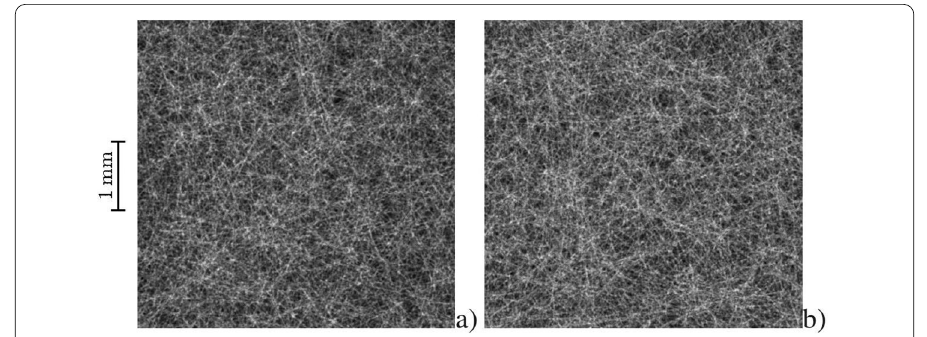
Figure 4 Realizations of random fields generated by segments of exponentially distributed lengths, 1024 × 1024 pixels of size 4.0 μ m, thickness of the tubes 6.0 μ m: a) mean length 0.5 mm, b) mean length 1